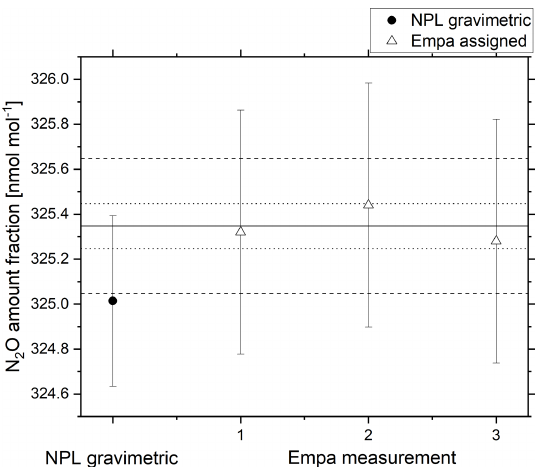
Figure 9. Gravimetric amount fraction (filled circle) and amount fraction certified by Empa (open triangle) against the NOAA/GMD reference scale for a 325nmolmol − 1 reference material. The solid black line represents the average value certified by Empa, the dotted lines represent the WMO-GAW DQO and the dashed lines represent the extended WMO-GAW DQO. Error bars represent the combined expanded uncertainty ( k =